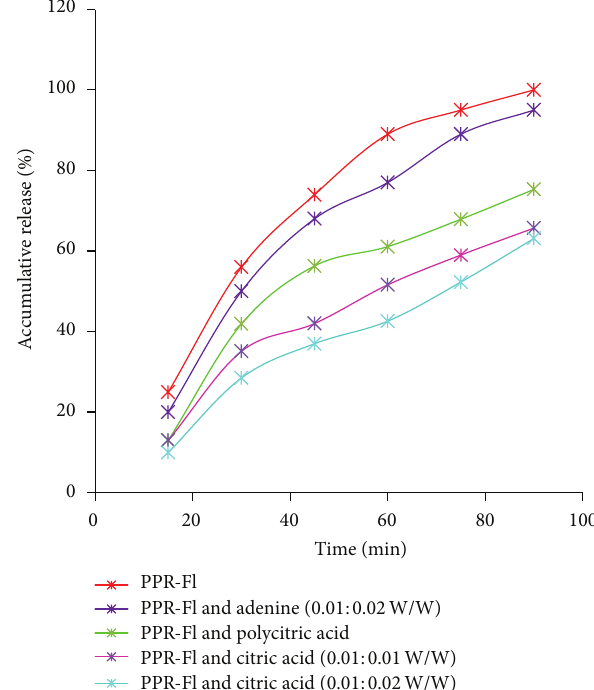
Figure 7: The rate of release of the secondary drug delivery system (cyclodextrin-fluorescein conjugates) from the primary drug delivery system in pH